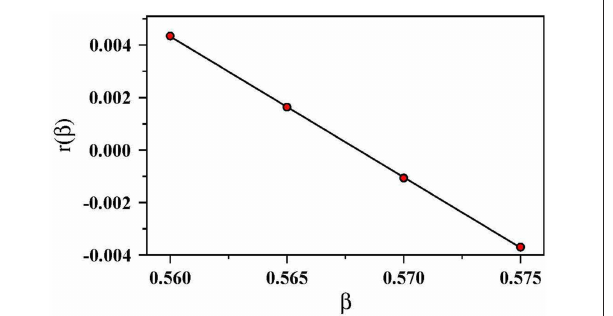
FIGURE 6 | Assortativity coefficient as function of β . The straight line is 0 . 305 − 0 . 537 β , leading to r ( β ) = 0 for β = 0 . 57 .